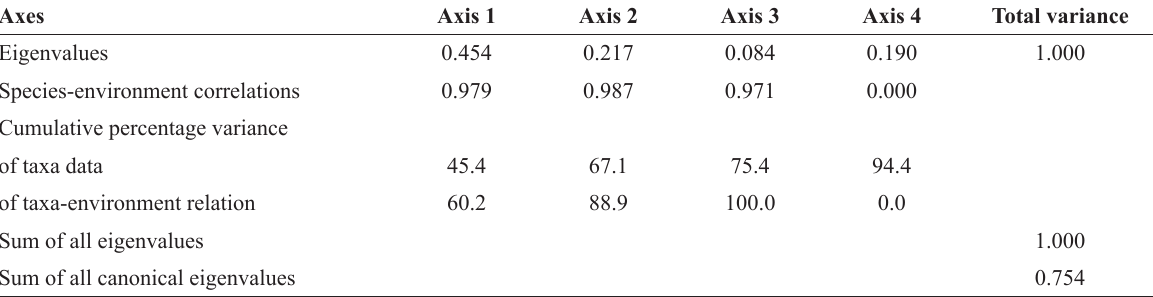
Eigenvalues, taxa-environment correlation coefficients, and cumulative percentage explained by the first four RDA axes of riffle beetle assemblages of streams in Parque Estadual do Turvo.